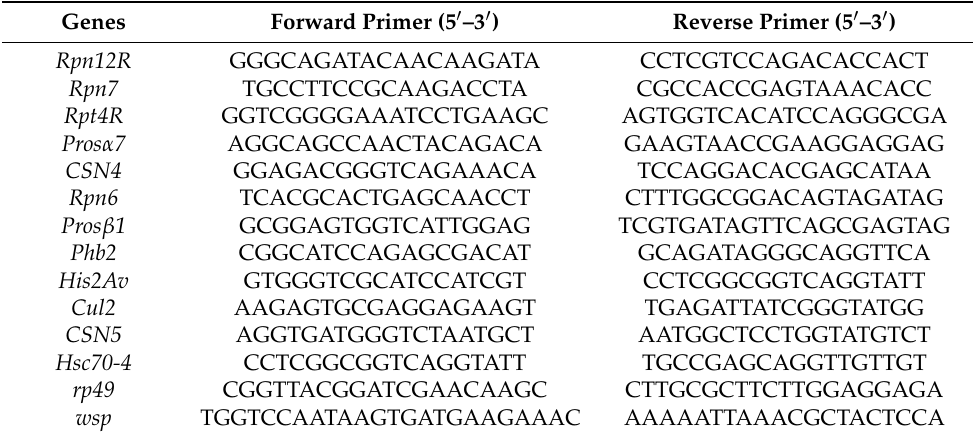
Table 1. Primers for qRT-PCR and PCR.